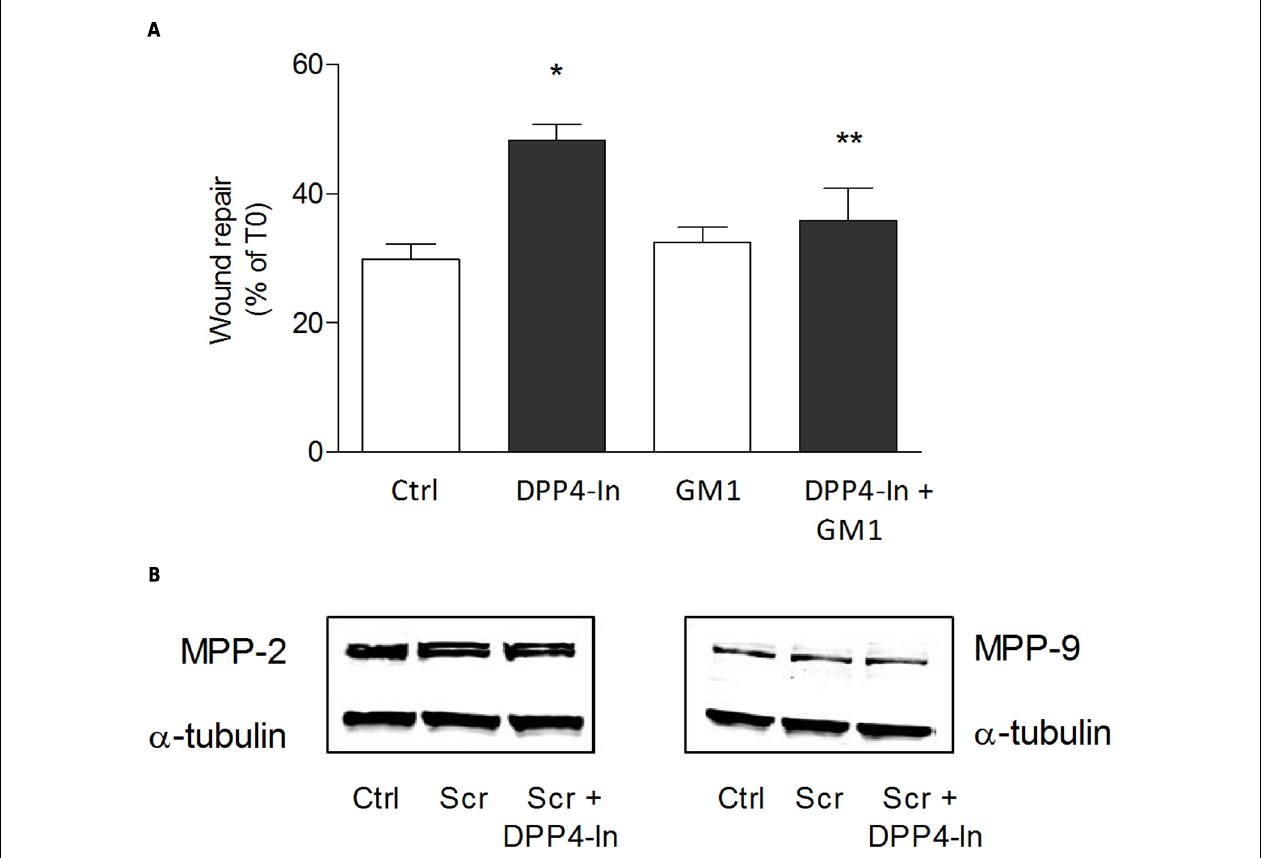
FIGURE 4 | DPP4-In requires MMPs to promote wound repair. The cell monolayer was scratched and pre-treated with the non-specific MMP inhibitor GM6001 (5 m M) for 30 min prior to addition of DPP4-In (10 m M) (A) . In (B) representative blots of MMP2 and MMP9 24 h after scratch in the presence and